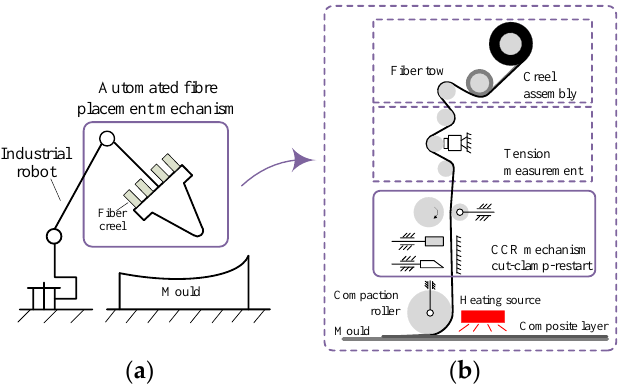
Figure 3. ( a ) An automated fiber placement system; ( b ) a single fiber transmission path.